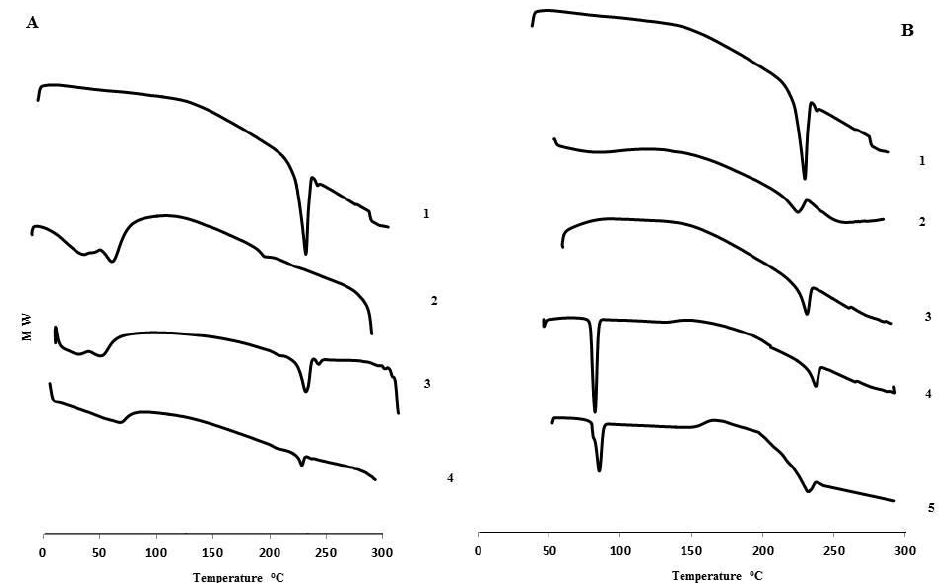
FIGURE 2 - (A) DSC thermograms of (1) Eplerenone, (2) β-CD, (3) physical mixture and (4) Eplerenone β-CD complex, (B) DSC Thermograms of (1) Eplerenone, (2) Ep/Carbopol 71 G physical mix., (3) Ep/HPMC K4M physical mix., (4) Ep/PEG 6000 physical mix., (5) Ep/PEO WSR 1105 physical